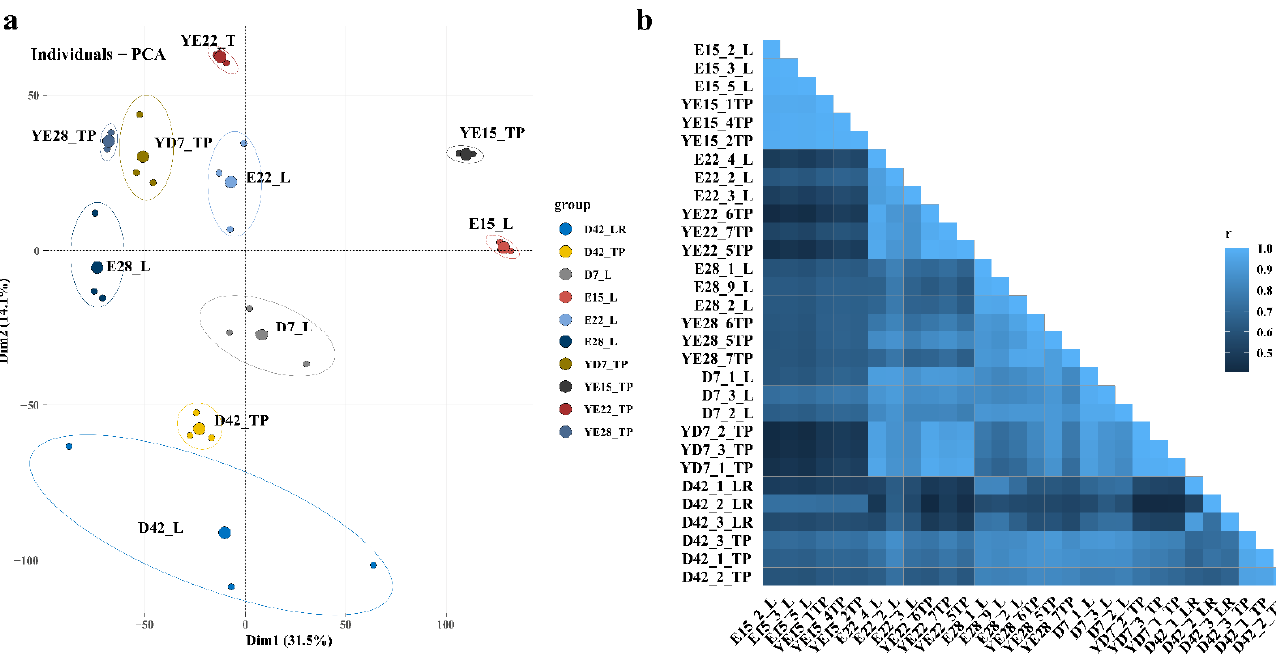
Figure 1. Sample correlation analysis. ( a ) PCA analysis of all RNA sequencing samples; ( b ) heat map of the correlation of all RNA sequencing samples. The shades of colors represent different correlation coefficients (r).